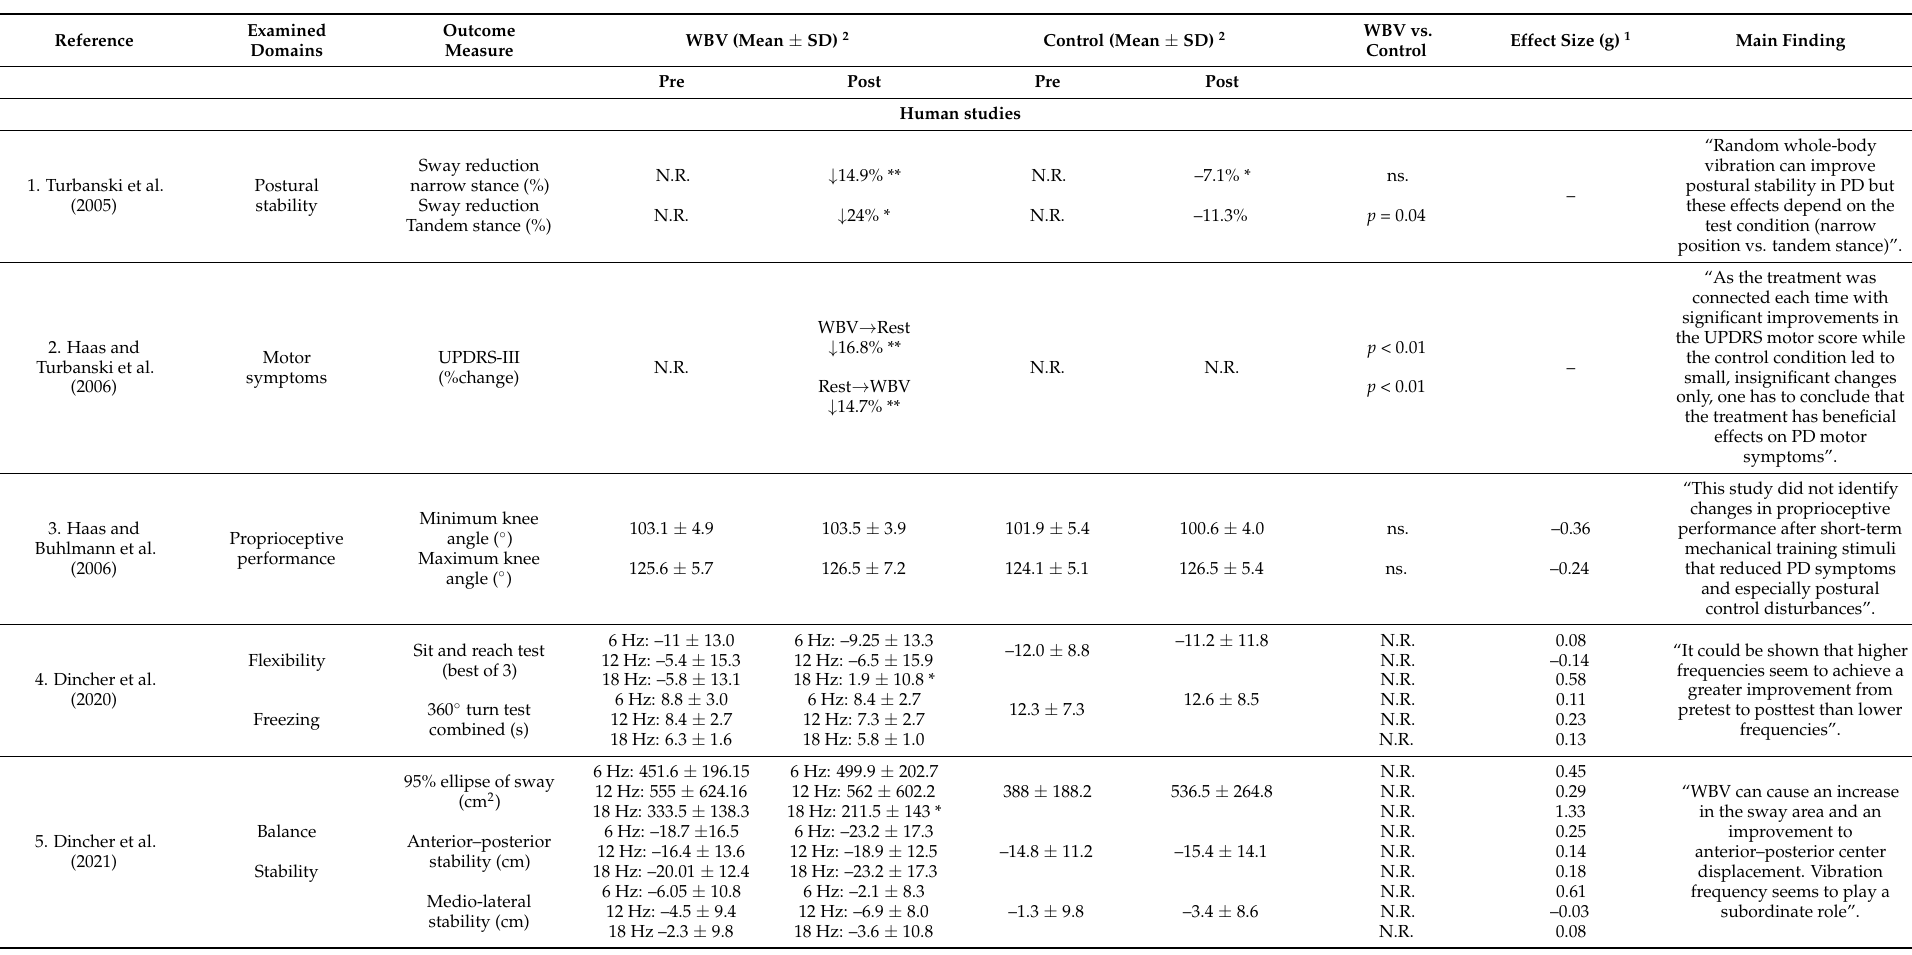
Table 2. Results of studies regarding the effects of WBV on PD patients or PD animal